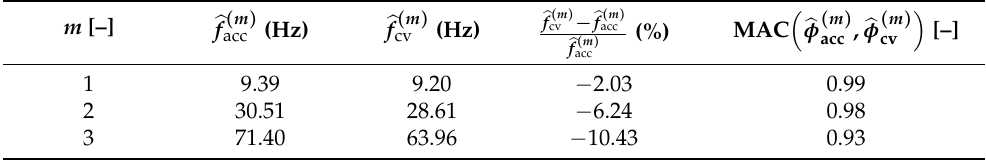
Table 4. Comparison of CV- and accelerometer-based identified modal